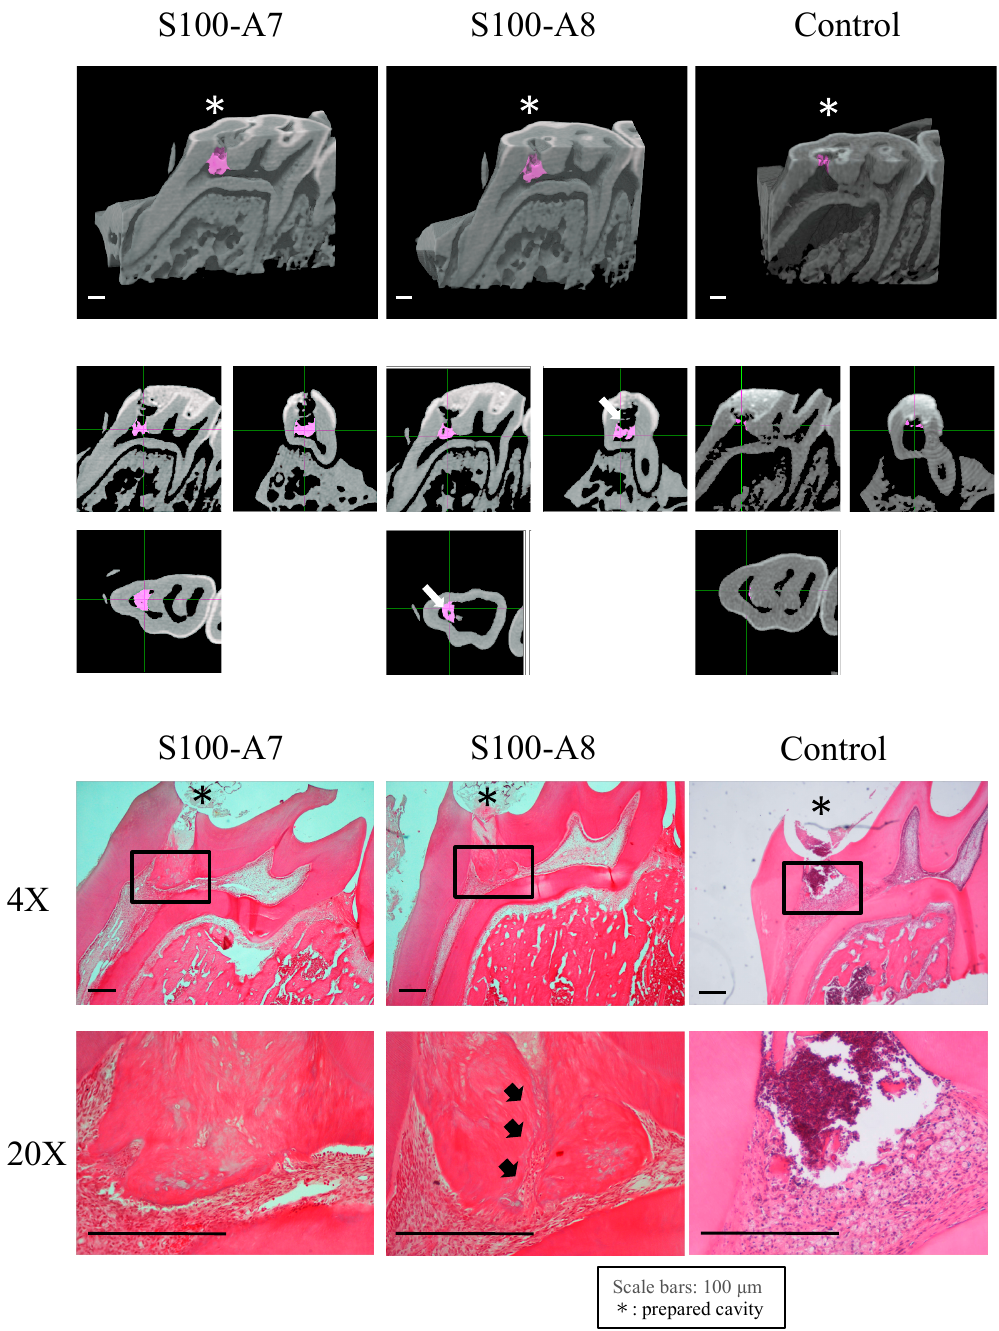
Figure 5. Effect of proteins S100-A7 and S100-A8 on tertiary dentinogenesis. Analyses of tertiary dentin using protein S100-A7 or S100-A8 as pulp capping materials. ( A ) Results of μ -CT. A tunnel defect in tertiary dentin is indicated by white arrows. ( B ) H-E-stained images. A tunnel defect in tertiary dentin is indicated by black arrows. Scale bar: 100 μ m (* = cavity). Images are representative of three independent experiments.